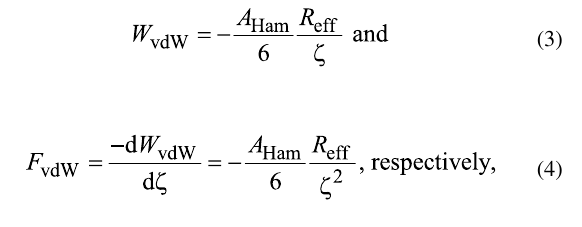
from each other. Interacting forces are not detectable and δ is zero which equals the free equilibrium position of the cantile- ver. Figure 1(II) regime of attractive forces: upon further ap- proach of the sample and the tip, attractive forces start to govern and the cantilever is bent towards the sample. The attractive forces between the sample and the tip increase up to a point at which they exceed the gradient of k c . Figure 1(ii) jump to con- tact (JTC): a discontinuity where the system is not in equilib- rium and the tip snaps onto the sample. Also at this point, the measurable maximum of the attractive forces is reached. Figure 1(iii) contact: attractive and repulsive forces are in balance and the cantilever reaches its equilibrium position again. Figure 1(III) contact line: upon further approach, the repulsive forces are dominant and the cantilever is pushed away from the sample. The deflection δ corresponds to the applied force, F rep , according to Equation 1. At a maximum deflection, δ max , ( F max ) the approach is stopped and the sample is with- drawn until the contact is lost at the jump-off-contact (JOC) and the zero line is reached again (only shown in Figure 1b, blue dashed line). In this study, only the approach part of the acquired curves is considered and evaluated. Hence, only attrac- tive forces from the approach part are evaluated, which are not identical to the adhesion forces, dominated by the force needed to separate the tip and the sample after a forced